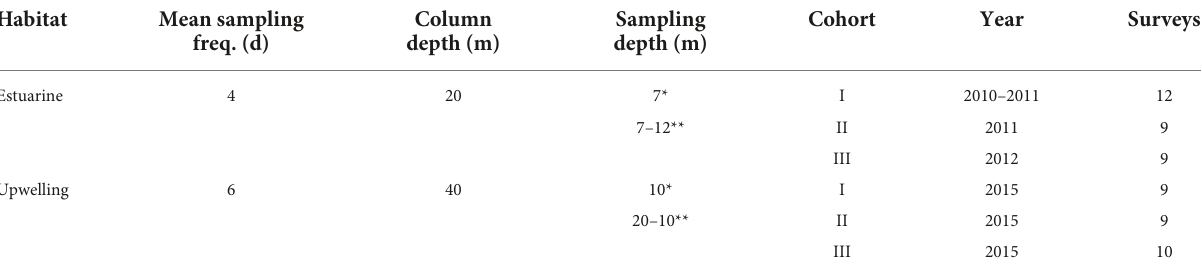
TABLE 1 Sampling information within each coastal habitat and